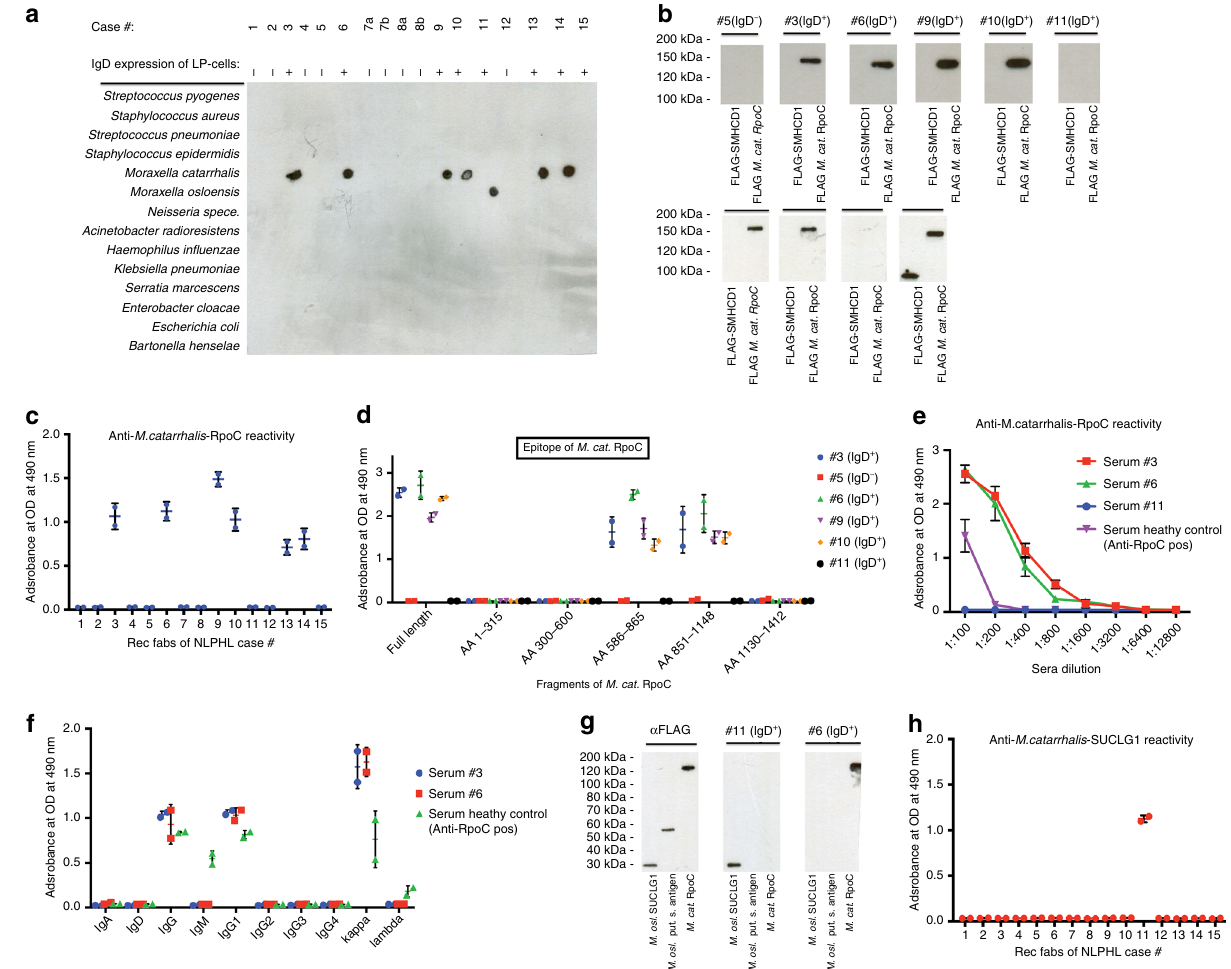
Fig. 1 Reactivity of recombinant IgD + LP cell-derived Fabs with bacterial lysates. a Representative Immuno-dot blots of bacterial lysates. NLPHL-derived recombinant Fabs of six cases bound to lysates of M. catarrhalis , and of one case to lysate of M. osloensis . Eight cases showed no reactivity against bacterial lysates. All six M. catarrhalis -reactive recombinant Fabs (#3, #6, #9, #10, #13, and #14) and the one M. osloensis- reactive Fab (#11) were derived from IgD + NLPHL cases. b Representative Western blot of recombinant C-terminally FLAG tagged M. catarrhalis RpoC expressed in HEK293 cells con fi rmed reactivity of lymphoma Fabs #3, #6, #9, #10, #13, and #14 with the recombinant bacterial antigen. A recombinant C-terminally FLAG-tagged SMCHD1 fragment was used as negative control. c ELISA with recombinant C-terminally FLAG-tagged M. catarrhalis RpoC as a coat demonstrated speci fi c reactivity of Fabs derived from LP cells of six patients (#3, #6, #9, #10, #13, and #14) against recombinant RpoC. Values are mean ± SD. d Determination of the epitope of RpoC recognized by IgD + NLPHL Fabs. Recombinant Fabs #3, #6, #9, and #10 bind AA 600 – 1130 of M. catarrhalis RpoC. Values are mean ± SEM. e Serum reactivity against RpoC in patients from whom recombinant NLPHL Fabs were derived. The two IgD + NLPHL patients with RpoC-reactive recombinant lymphoma Fabs (#3 and #6) had higher anti-RpoC-antibody serum titers (1:1600) than a healthy control with anti-RpoC-antibodies (1:200). The IgD + NLPHL patient with the M. osloensis -speci fi c Fab (#11) had no serum anti-RpoC-antibodies. Values are mean ± SD. Experiments were independently repeated three times. f : Immunoglobulin classes and subclasses and light chains of serum RpoC antibodies from the two patients with RpoC-reactive BCR of the LP cells (#3 and #6) and a seropositive healthy control. Patients #3 and #6 both show a predominance of IgG1/ κ . The healthy control had additionally anti-RpoC-antibodies of IgM class and in contrast to patients #3 and #6 no clear light chain restriction. Values are mean ± SD. g Representative Western blot of FLAG-tagged M. osloensis SUCLG1 expressed in HEK293 cells con fi rms reactivity of lymphoma Fab #11 with the recombinant bacterial antigen. h ELSIA with recombinant M. osloensis SUCLG1 as a coat demonstrated speci fi c reactivity of Fabs derived from LP cells of patient #11 against recombinant SUCLG1. Values are mean ± SD. Data in a – c , e , and f are representative of three independent experiments each; data in d , g , and h are representative of two independent (Fig. 1e). High-titer, anti- M. catarrhalis -RpoC antibodies were relation to the initiating event of NLPHL. The titers ranged from found in 20/98 NLPHL patients enrolled in clinical trials con- 1:800 to 1:3,200 (Fig. 2c). When applying a titer higher than 1:400 ducted by the German Hodgkin Study Group (GHSG) (Fig. 2a), as cut off for positivity, no healthy control or patient with cHL or which is representative of the general population of NLPHL THRLBCL was positive. High titer (>1:400) serum antibodies patients. All anti- M. catarrhalis -RpoC antibodies were of IgG class against M. catarrhalis RpoC were associated with NLPHL ( p < and predominantly of the IgG1 subclass (Fig. 2b), thus probably 0.0001; Fisher ’ s exact test). Low-titer RpoC-antibodies were not related to the IgD + LP cell clone. However, in each patient detected in the serum of 9/188 healthy controls (Supplementary with serum antibodies against RpoC, these were light chain Fig. 8) and in 10/100 patients with classical HL (Fig. 2d), with restricted (Fig. 2b), indicating a clonal origin and presumably a maximum titers of 1:200 (Fig. 2e, Supplementary Figs. 9 and 10).